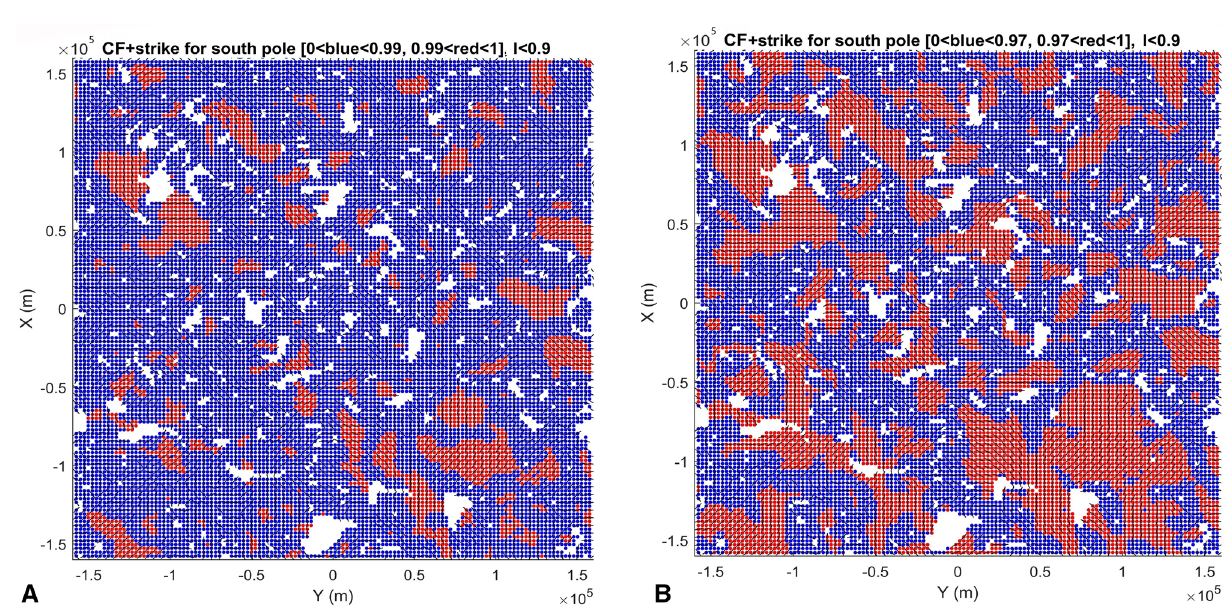
Figure 4. Stability of the comb factor (CF) within the area of south pole of the Moon. Dimensions are in meters. ( A ) Left panel corresponds to the strike angle plot and its CF for the south pole in Fig. 2A. The CF between 0.99 and 1.00 is in red color while the lower CF is in blue color. ( B ) Right panel shows CF between 0.97 and 1.00 in red color while the lower CF is in blue (blue symbol is larger for contrast clarity). Black letter P shows significant extent of CF-detected pores in the areas of Aitkin basin. Both plots are strike angles for ratio I < 0.9 (see Eq. 2), sensitive to weakness directions of the rocks in subsurface structures near the north pole of the Moon. Data were plotted using MATLAB